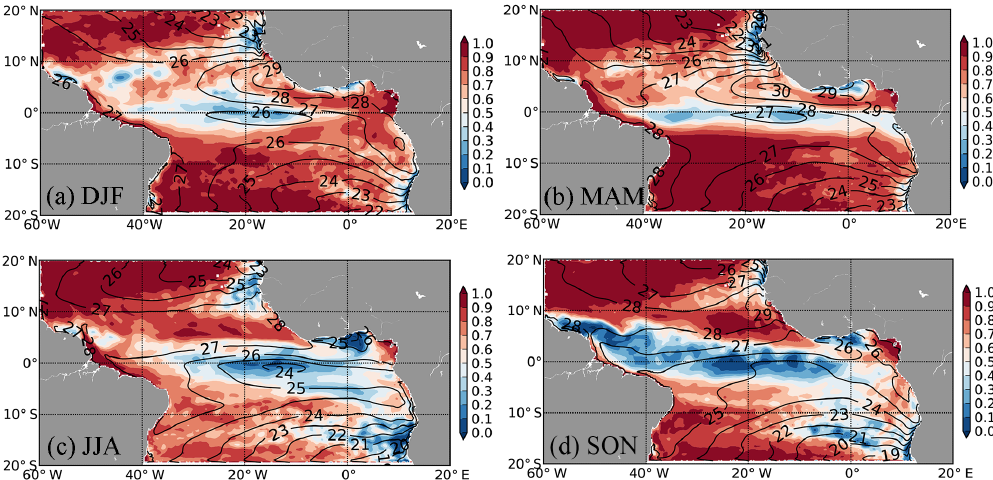
Figure 4. Coefficient of determination ( R 2 ) between REF and REF- τ clim seasonal SST time series. R 2 has been computed at each model grid point using data from 1979 to 2015 and with temperatures averaged over four seasons: December–January–February (a) , March–April– May (b) , June–July–August (c) and September–October–November (d) . Values close to 1 indicate that seasonal SSTs in the two simulations are highly correlated, suggesting a thermodynamic control of the interannual variability, while values close to 0 indicate that seasonal SSTs in the two simulations are uncorrelated, suggesting a dynamic control of the interannual